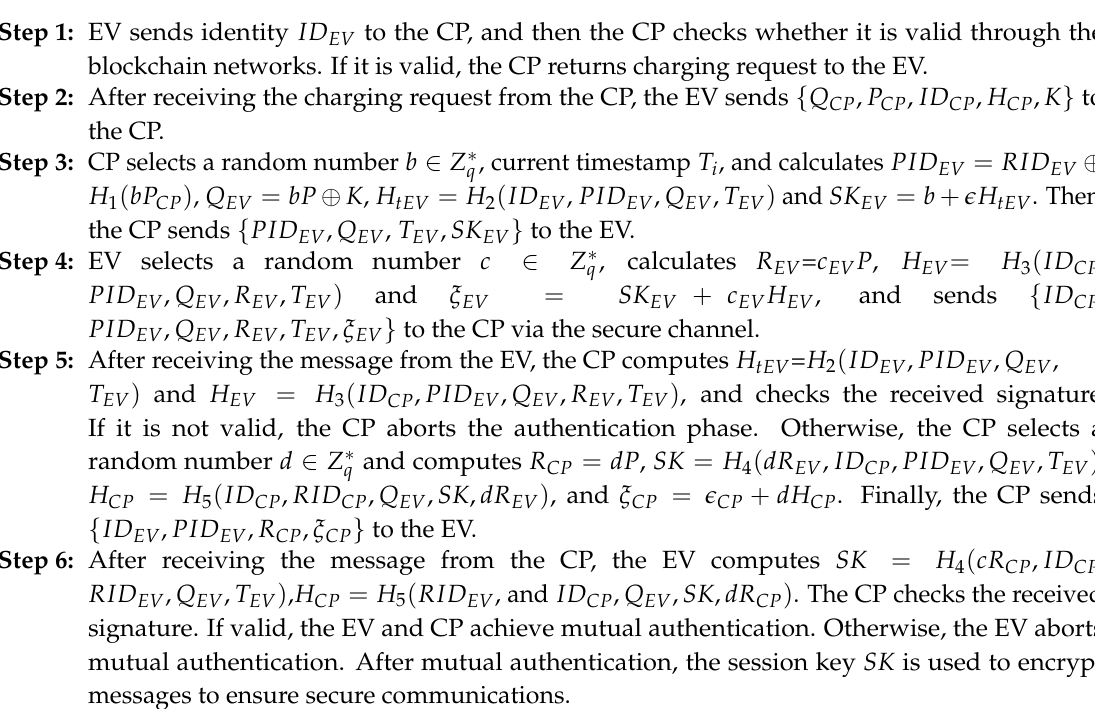
Figure 4. Authentication phase of Huang et al.’s